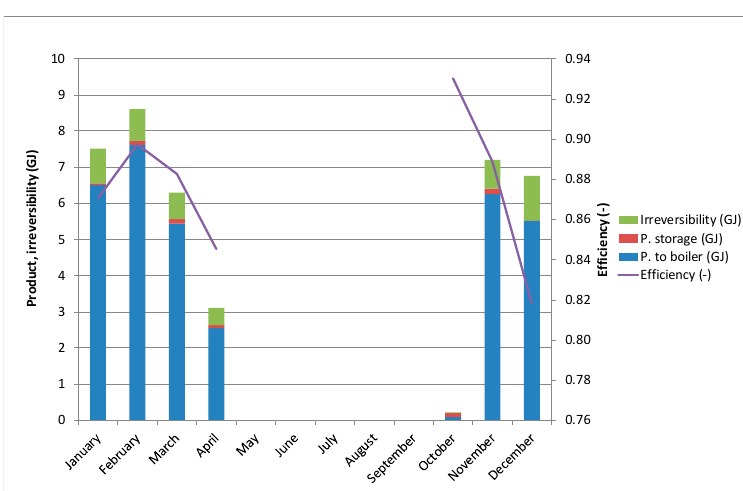
Figure A2. Secondary storage: Product, irreversibility, and efficiency.